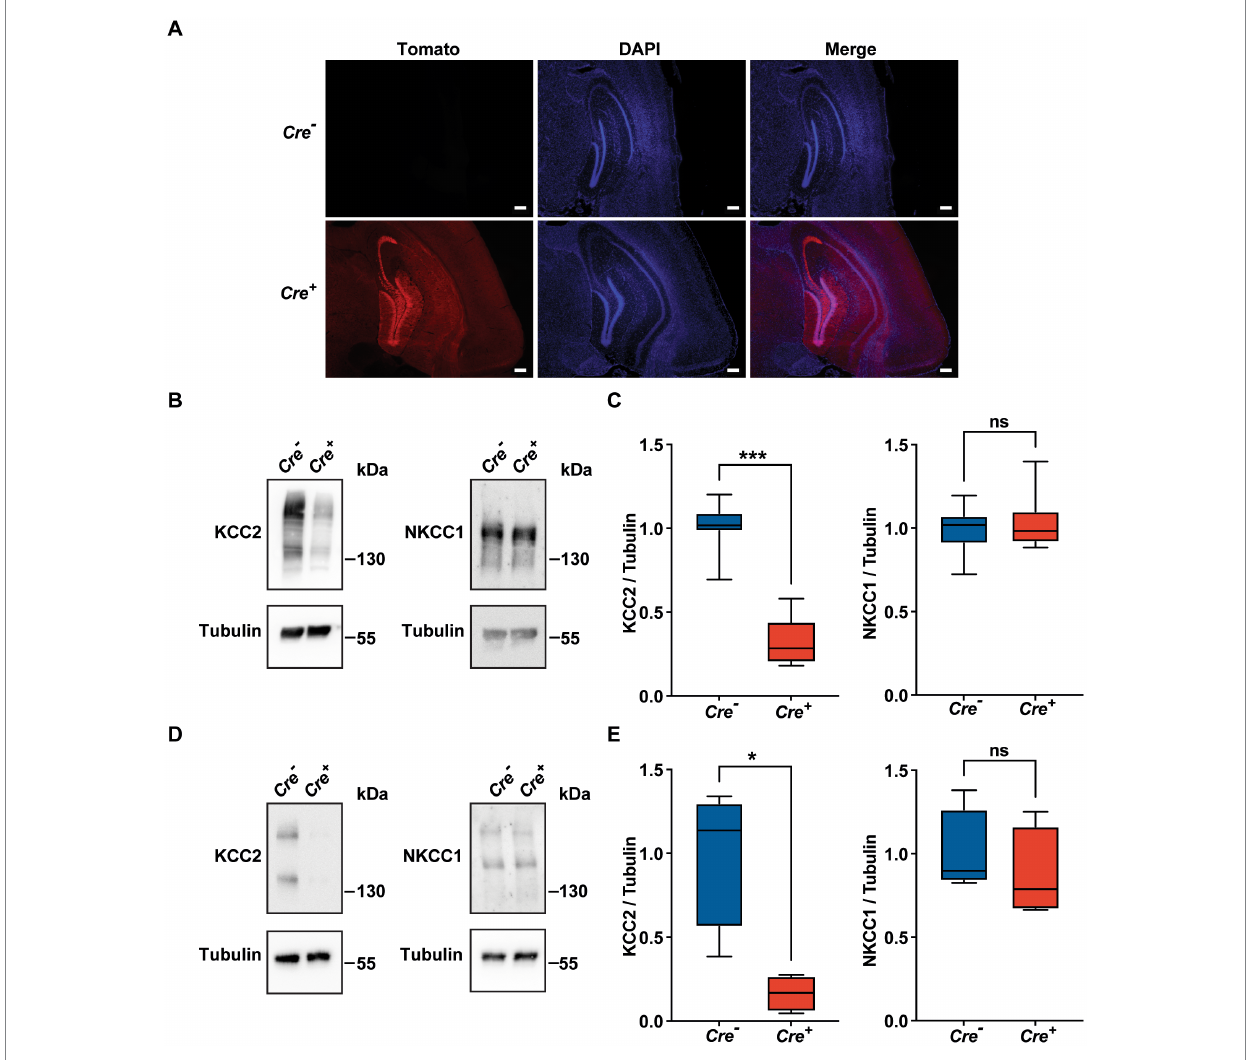
FIGURE 1 Validation of the KCC2 lox/lox CamKII α -CreERT2 mouse model. (A) Neuronal expression of rosaTomato in the cortex and hippocampus after tamoxifen treatment with DAPI counterstaining in Cre + and Cre-genotypes . Scale bar: 200 μ m. (B-E) Quantification and representative Western blots of KCC2 and NKCC1 protein levels of whole hippocampi tissue lysates ( n = 7; (B,C) and of CA1 regions lysates ( n = 4; D,E) of 3 month-old animals. Protein amount was normalized to β -tubulin and expressed as the proportion of the mean KCC2/ β -tubulin ratio of Cre-samples . (* p ≤ 0.05; *** p ≤ 0.001; Mann–Whitney